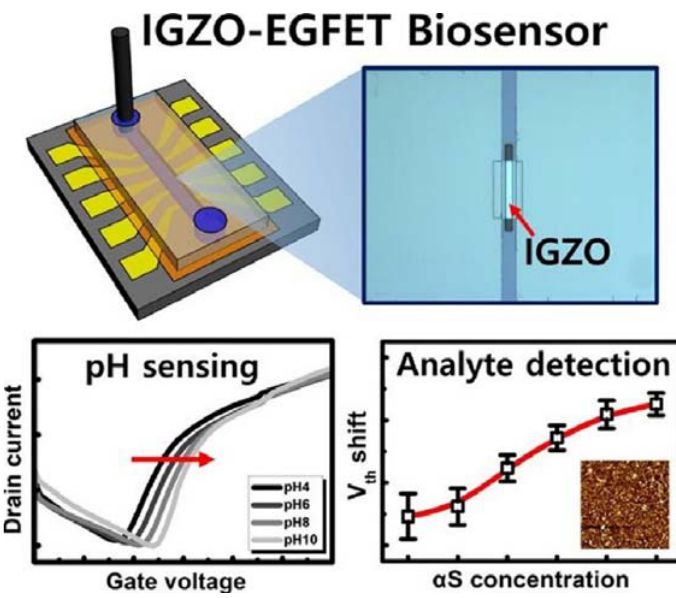
Figure 7. Top—schematic structure of the integrated system. Bottom—variation of the characteristic response as a function of the pH (left) and threshold voltage (V th ) as a function of α -synuclein ( α S) concentration (right). Reprint by permission from Elsevier.